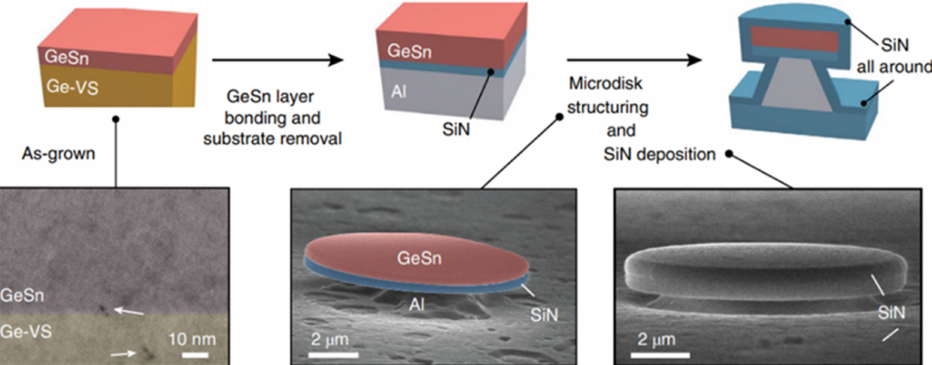
Figure 31. Fabrication process for a GeSn microdisk laser with SiN x all-around. Reproduced with permission from [80], Springer Nature, 2020.